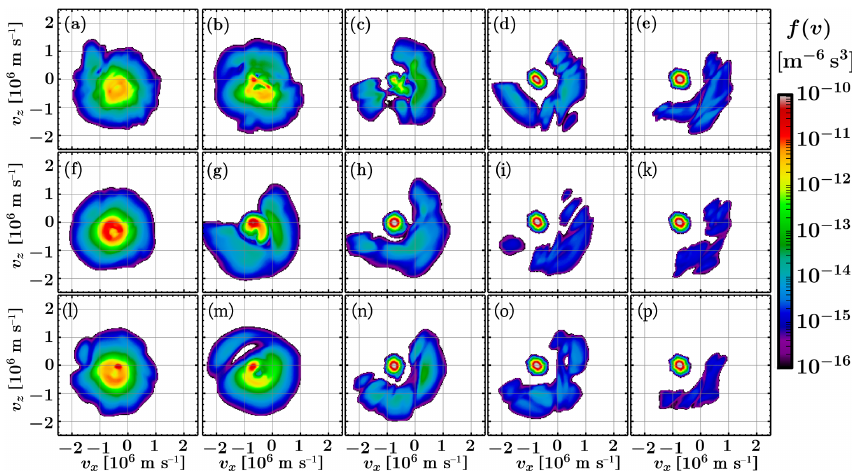
Figure 6. Cuts of the proton velocity distribution function at time t = 1187 . 85 in the v x – v z plane (at v y = 0) at fifteen positions (labelled a – p ). The positions and the cuts they were chosen from are shown in Fig. 5. Each row corresponds to one cut, with panels from left to right going from the magnetosheath to the bow shock, then an SHFA, then a caviton further out, and finally an upstream position without transient